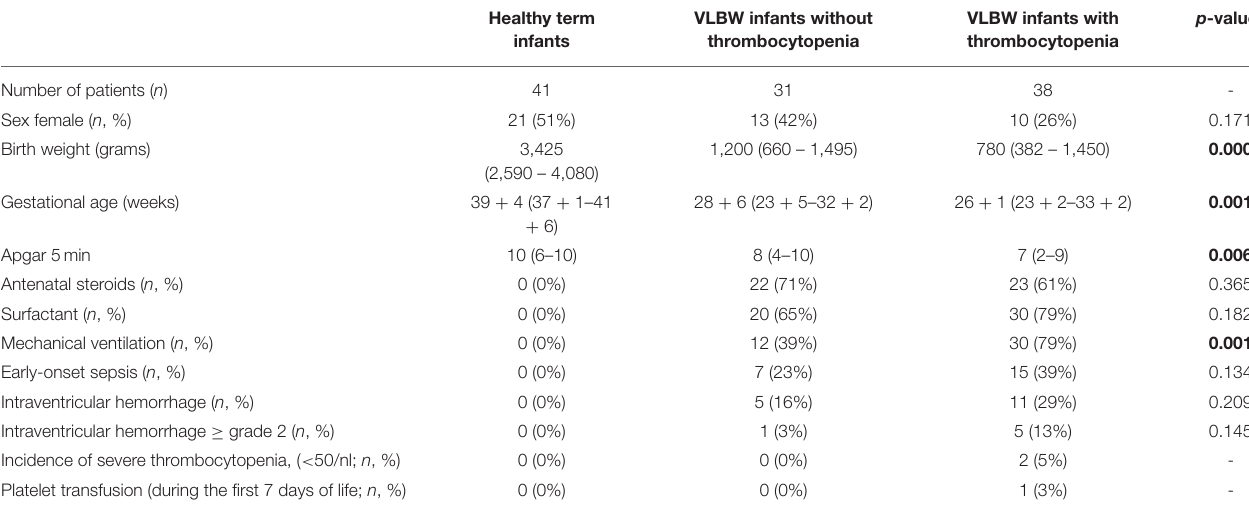
Healthy term VLBW infants without infants thrombocytopenia